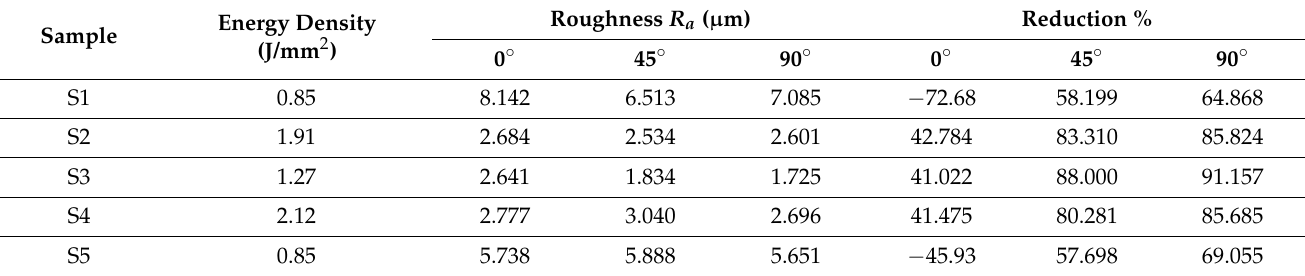
Table 6. Roughness measurements after polishing and reductions compared with the initial measured roughness